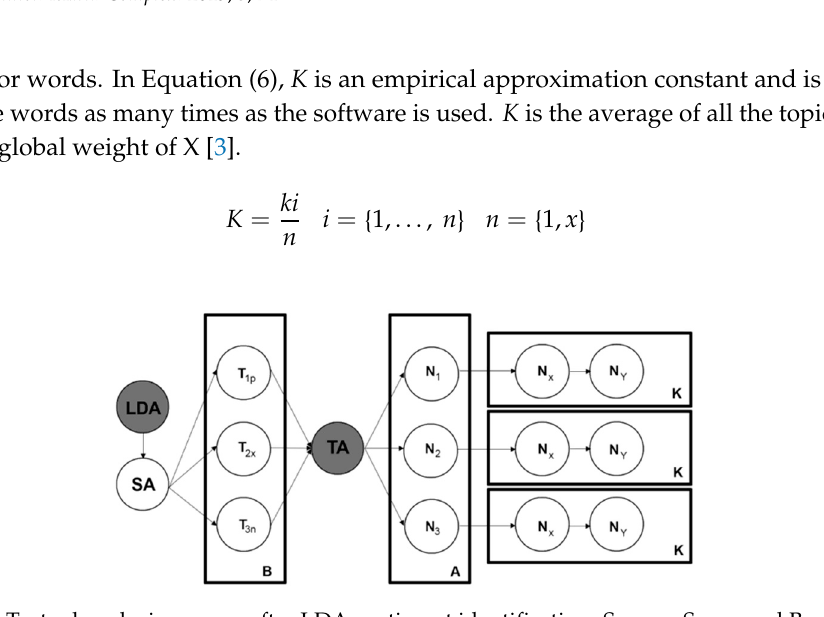
Table 1. MR measurements.